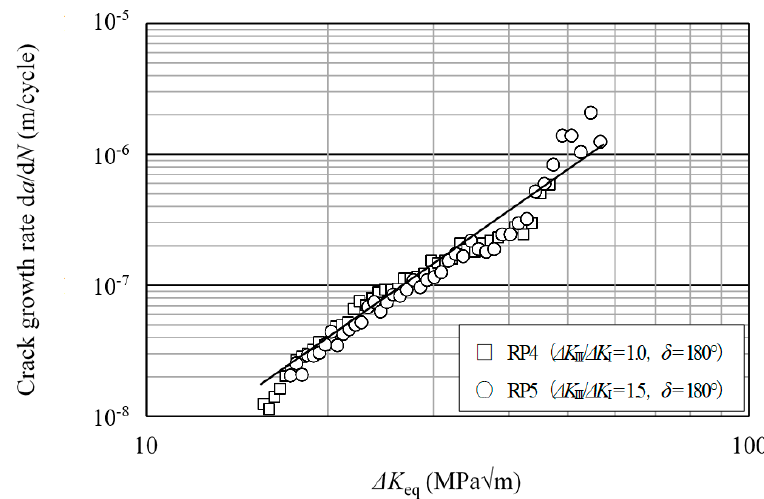
Figure 11. Branch crack growth rates against Δ K eq for RP.